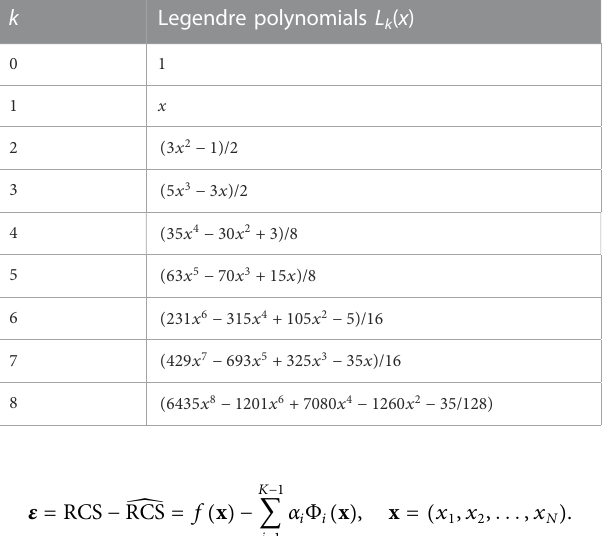
TABLE 2 One dimensional Legendre polynomials of the fi rst eight orders ( k goes from 0 to 8).